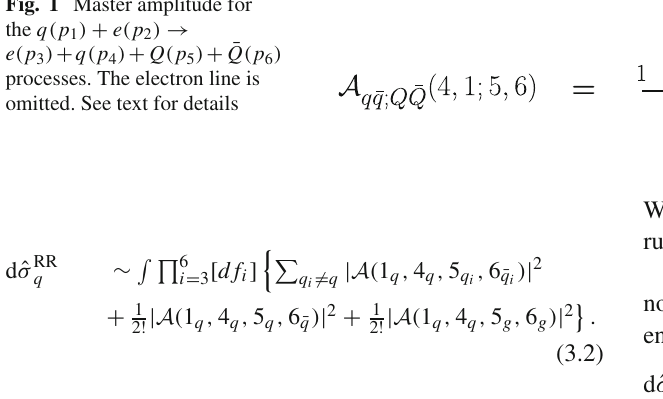
Fig. 1 Master amplitude for the q ( p 1 ) + e ( p 2 ) → e ( p 3 ) + q ( p 4 ) + Q ( p 5 ) + ¯ Q ( p 6 ) processes. The electron line is omitted. See text for